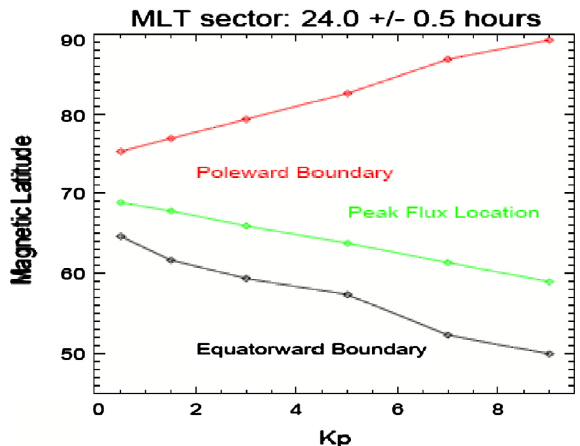
Fig. 4. Equatorward and poleward auroral boundaries and peak flux location obtained with the Zhang & Paxton (2008) model for different levels of magnetic activity (